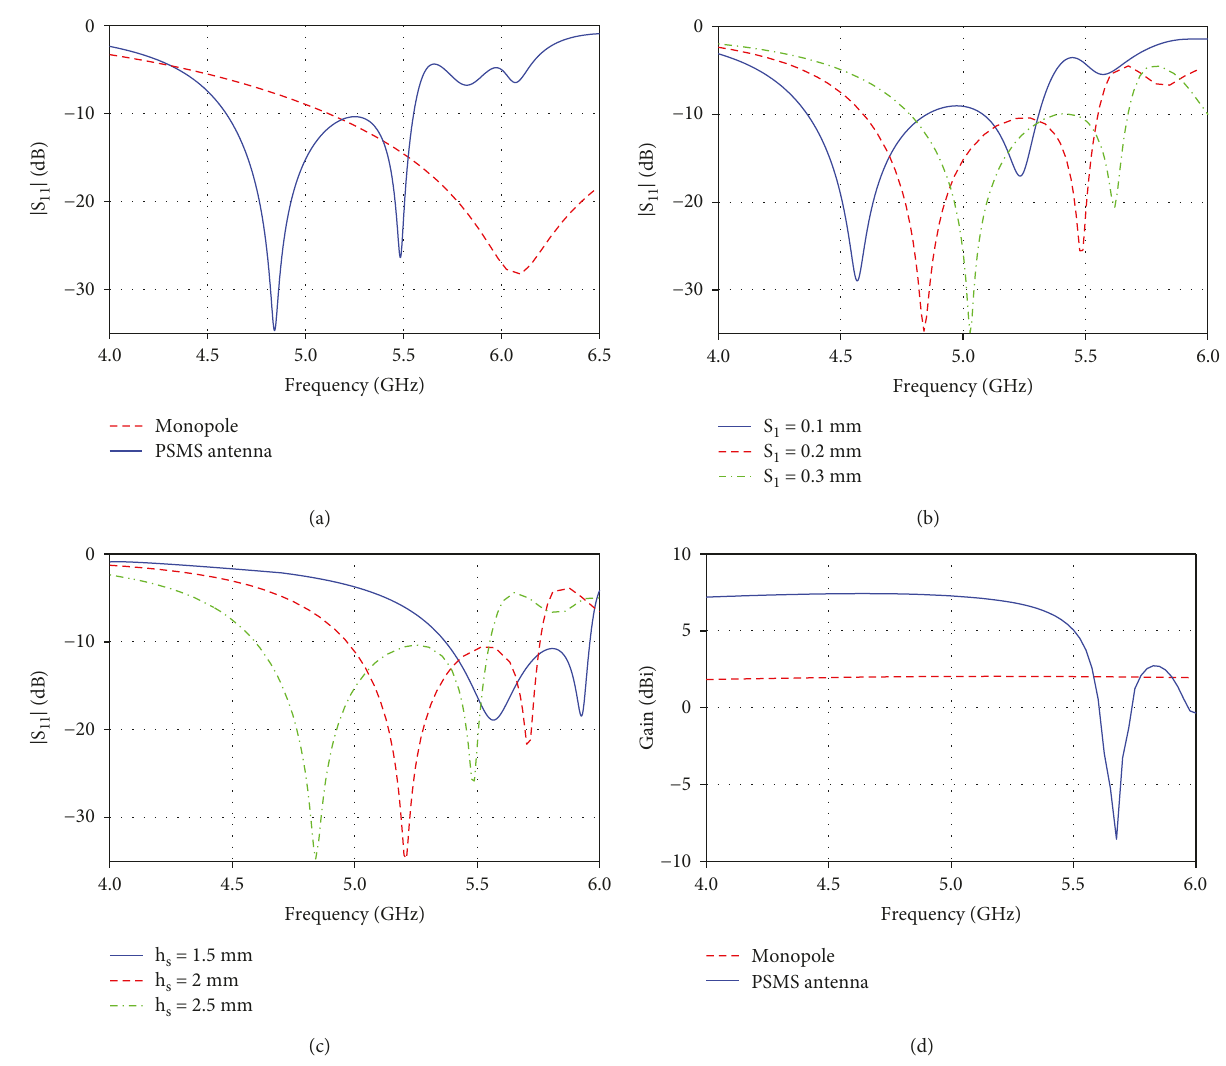
∣ between monopole and PSMS antenna. (b) Parametric study on slot gap s Figure 4: (a) Comparison of ∣ S 11 of PSMS substrate h . (d) Simulated gain of the monopole and the PSMS s